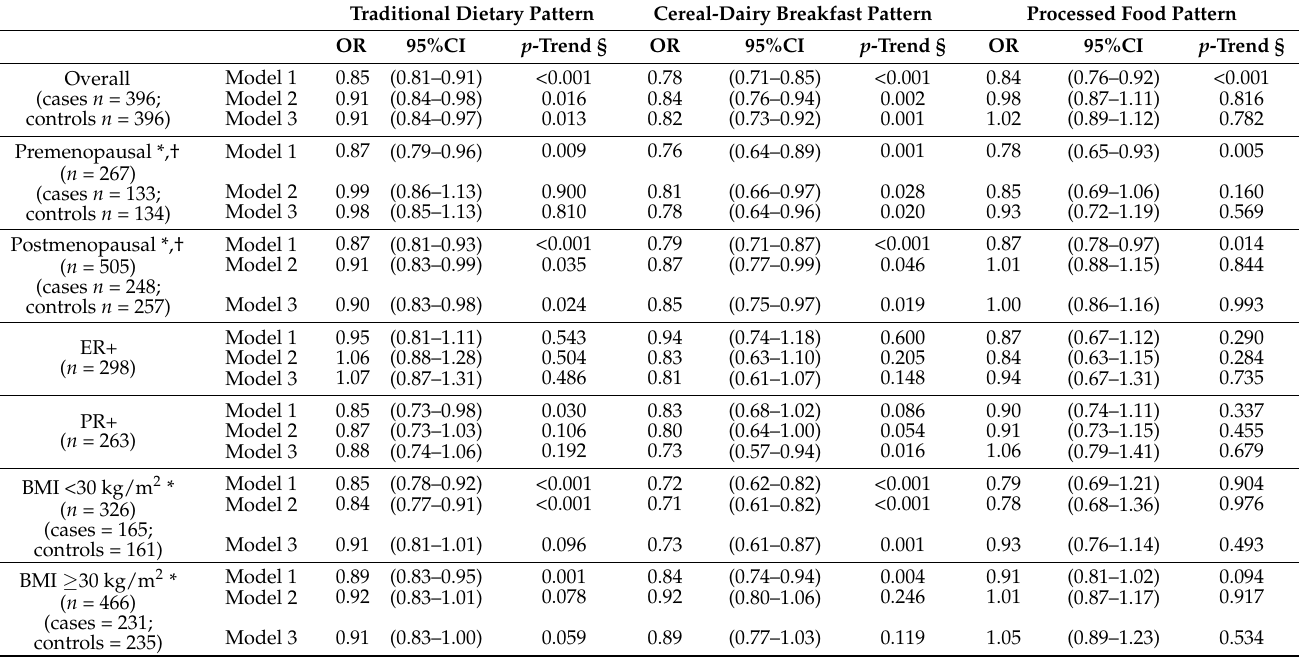
Table A2. The association between dietary patterns (per one standard deviation increase) and risk of breast cancer. Traditional Dietary Pattern Cereal-Dairy Breakfast Pattern Processed Food